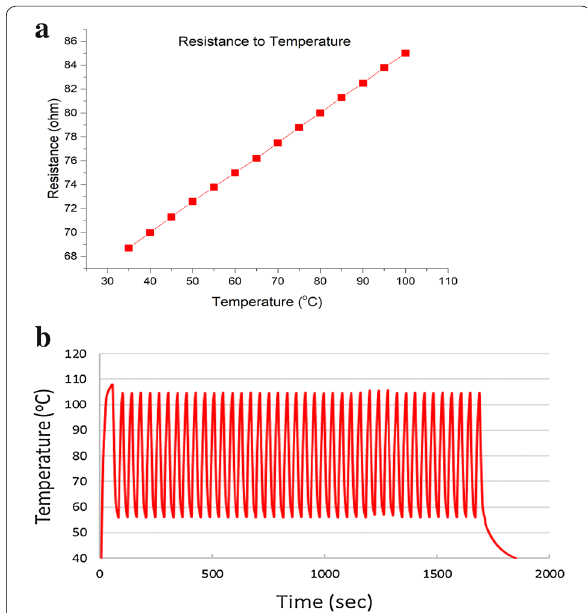
Fig. 2 a Resistance value of the RTD as a function of temperature and b thermal cycling curves of the microdevice (predenaturization step 99 °C, 30 s; denaturization step 99 °C, 5 s; annealing step 44 °C, 5 s; extension step 72 °C, 0 s) with 10 μL solution, showing a ramping rate of about 8 K/s employing an integrated polyimide‑heating device. The maximum power consumption is about 0.6 W at each chamber at an operating temperature of 99 °C Fig. 3 a The original DNA amplification PCR fluorescence results